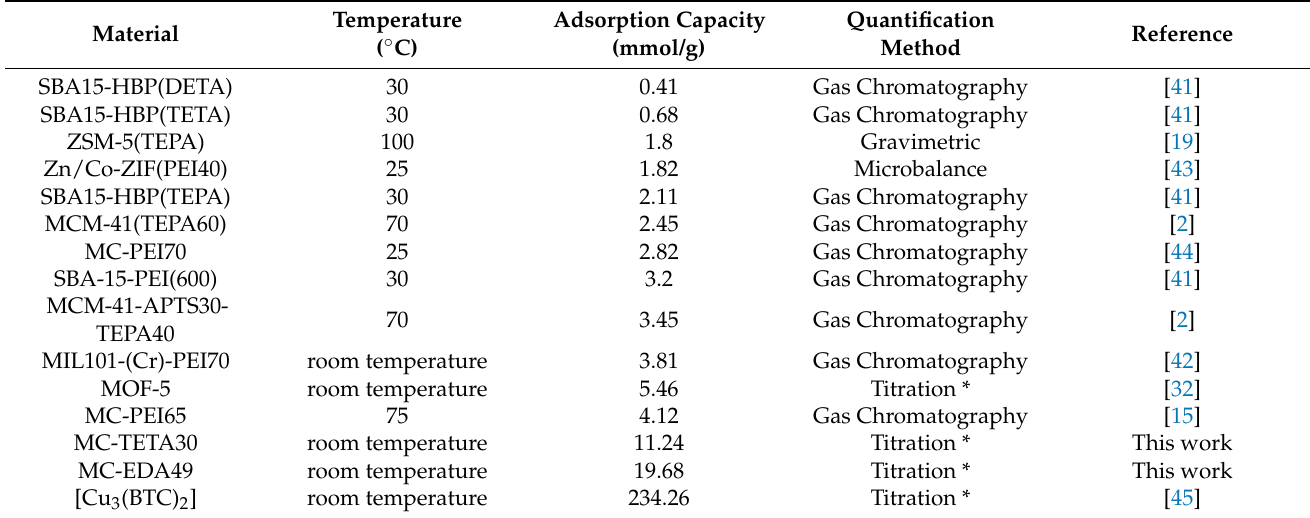
Table 2. Amine-modified materials tested for CO 2 adsorption from the literature and this work.